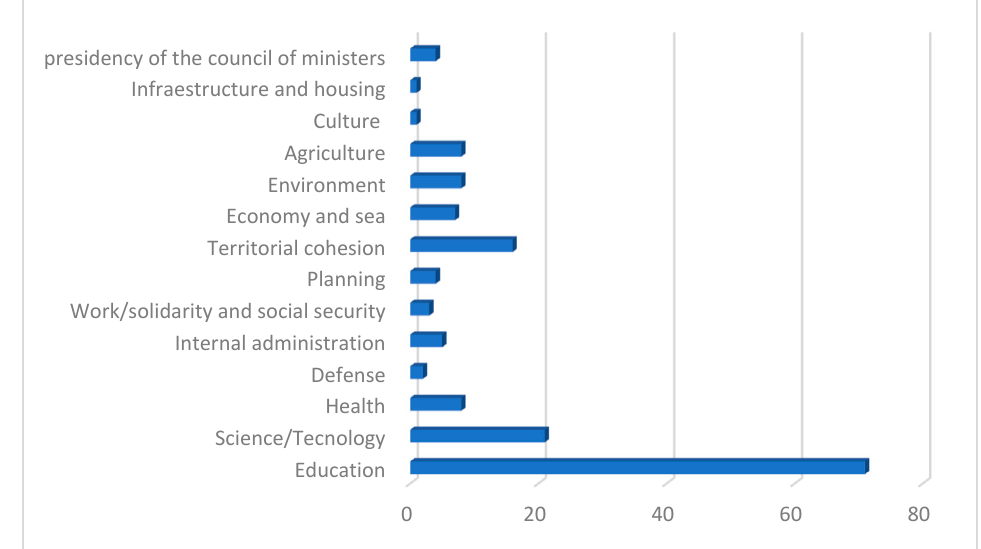
Figure 4. Distribution of participants according to the organisation at which they work.